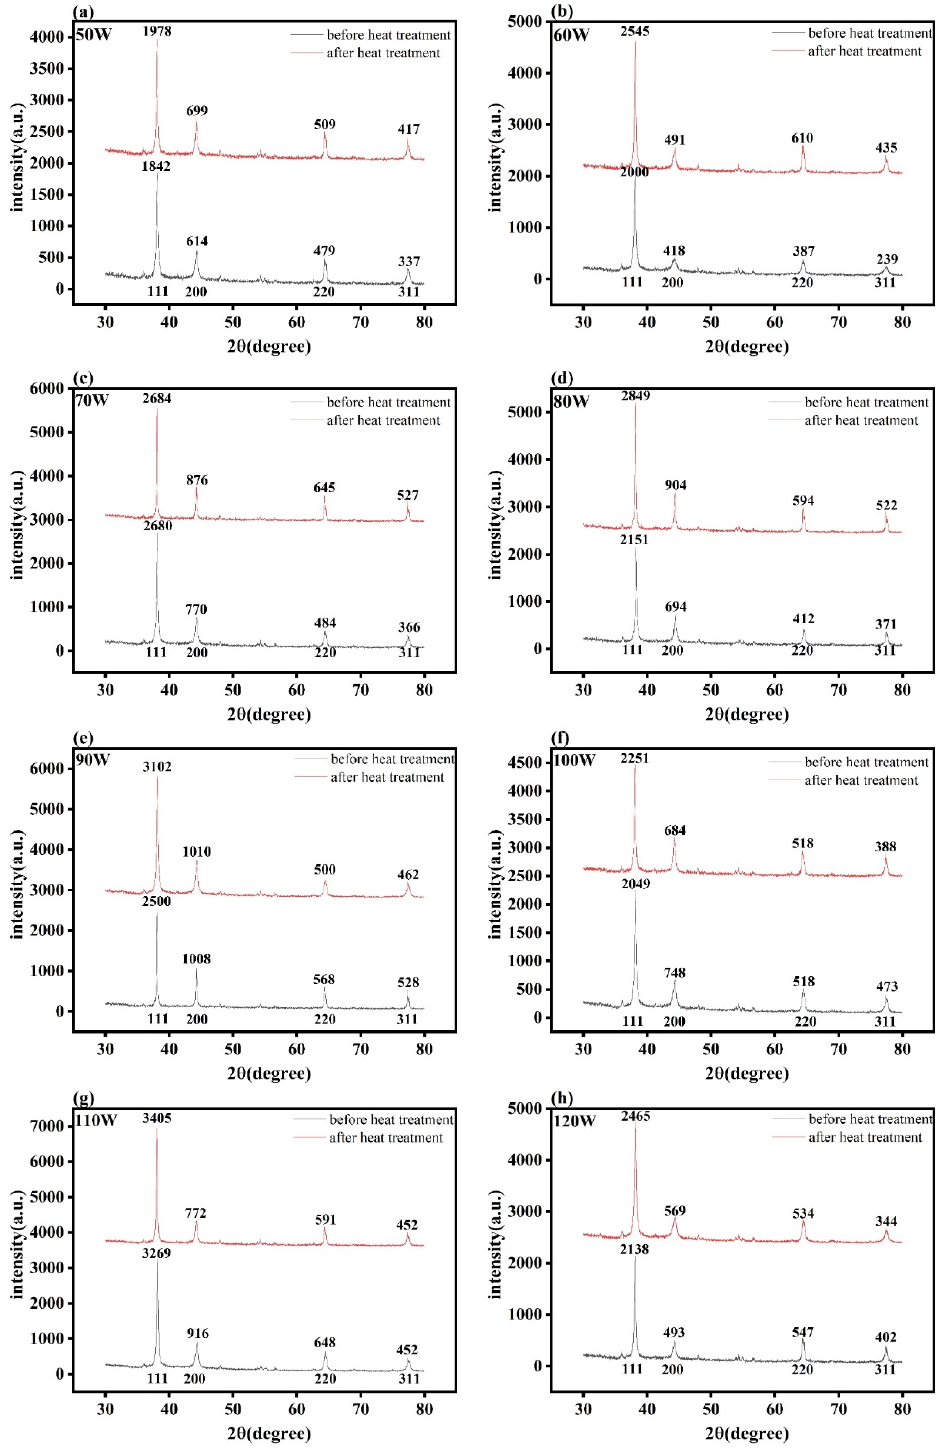
Figure 8. XRD figures of Ag layers before and after heat treatment. ( a ) XRD figure of Ag layers at 50W; ( b ) XRD figure of Ag layers at